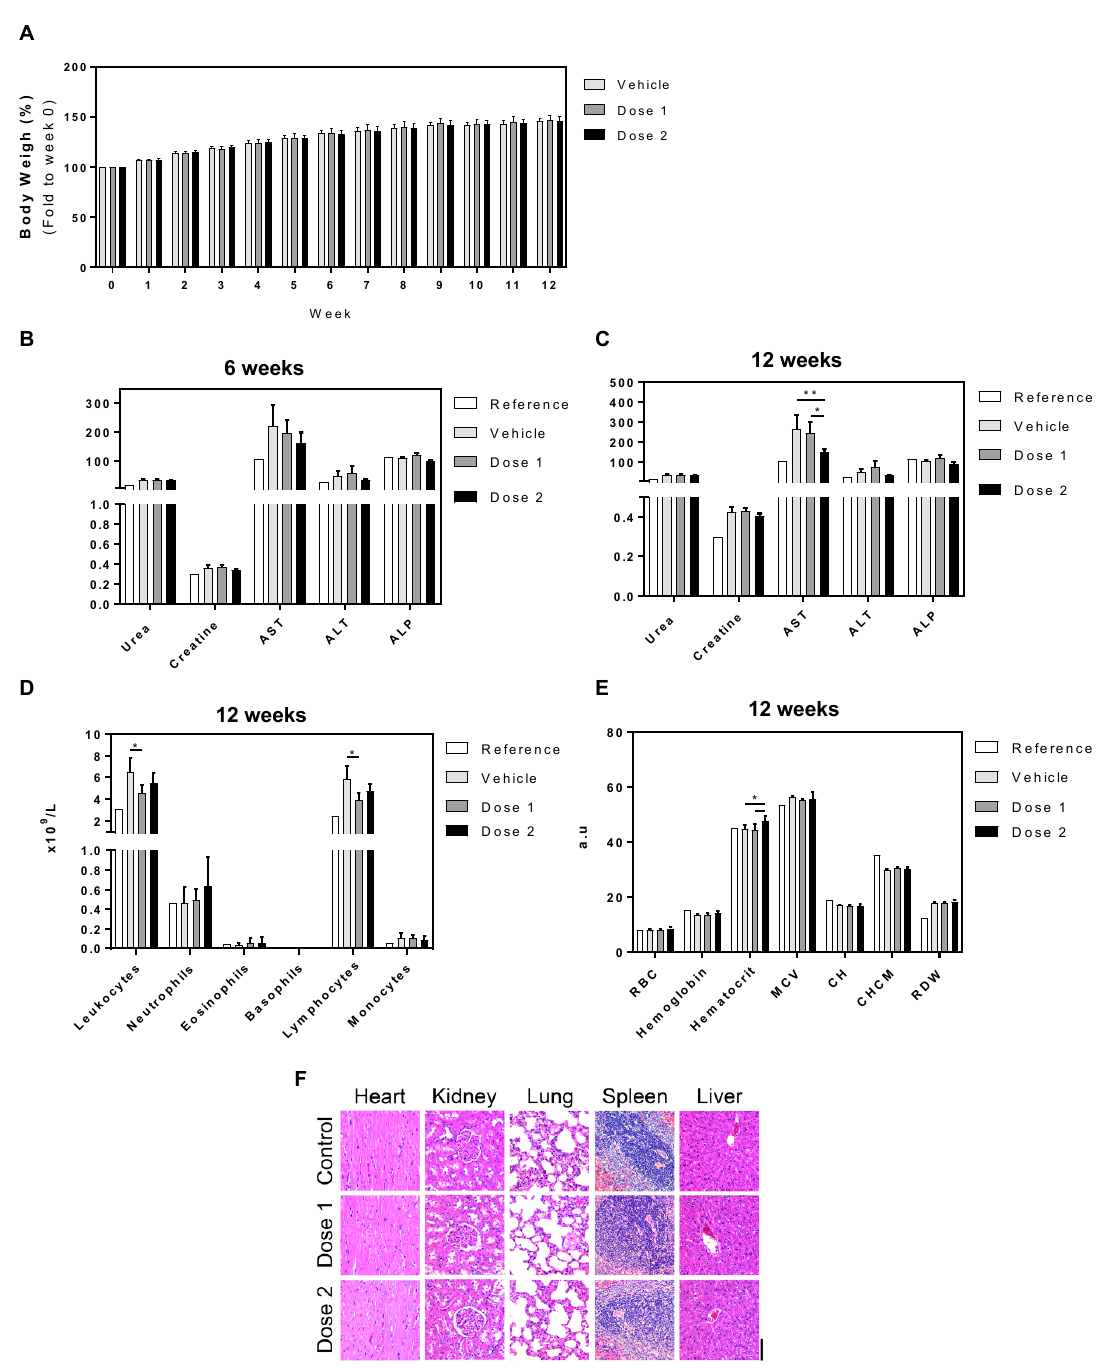
Figure 3. Toxicological profile of UCB-MNC-sEV in rats after repeated dose treatment (6 and 12 weeks). Wistar Han rats were injected intravenously with two UCB-MNC-sEV doses, twice a week for 6 or 12 weeks. Doses 1 and 2 refer to 1 × 10 10 and 1 × 10 11 particles/mL (1 × 10 9 and 1 × 10 10 total particles), respectively. After sacrifice, organs and blood were collected for analysis. Control (vehicle) animals were injected only with saline solution (PBS). ( A ) Graphic representation of weight evolution during the 12-week experiment. Graphic representation of ( B , C ) biochemical, ( D ) leukogram, and ( E ) hemogram results acquired at the end of the experiment. Reference values were obtained from Charles River. Results are presented as mean ± SEM. Statistical analysis was performed by ANOVA ( n = 7 rats per condition). If not otherwise marked, no statistically significant differences were found between vehicle and dose 1 or dose 2. * for p value < 0.05, and ** for p value < 0.01 ( F ) Representative H&E microphotographs of heart, kidney, lung, spleen, and liver from untreated and treated rats exposed to two different doses. Original magnification 20 × (bar, 100 µ